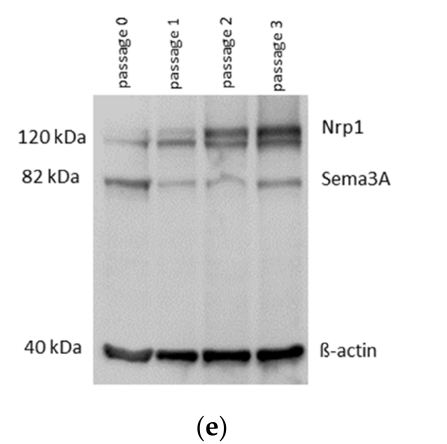
Figure 2. Influence of passage number on Sema3A and Nrp-1 expression in OA chondrocytes. ( a ) Relative NRP1 gene expression in OA chondrocytes in passage 1, 2 and 3 in comparison with passage 0 (control). One sample t-test; n = 13 for passage 0 and 1, n = 5 for passage 2 and 3, * p ≤ 0.05; ( b ) Relative SEMA3A gene expression in OA chondrocytes in passage 1, 2 and 3 in comparison with passage 0 (control). One sample t-test; n = 5–13, * p ≤ 0.05; ** p ≤ 0.01; ( c ) Relative protein expression of Nrp1 was analyzed via Western blotting and determined densitometrically in passage 0 (P0), 1 (P1), 2 (P2) and 3 (P3). Expression of β-actin served as endogenous loading control; n = 4, * p ≤ 0.05; ( d ) Relative protein expression of Sema3A was analyzed via Western blotting and determined densitometrically in passage 0 (P0), 1 (P1), 2 (P2) and 3 (P3). Expression of β-actin served as endogenous loading control; n = 4, * p ≤ 0.05; ( e ) Representative Western blot image for Nrp1, Sema3A, and β-actin protein expression in chondrocytes from OA patients expanded in monolayer until passage 3.